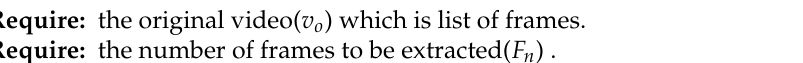
Algorithm 1 Frame selection